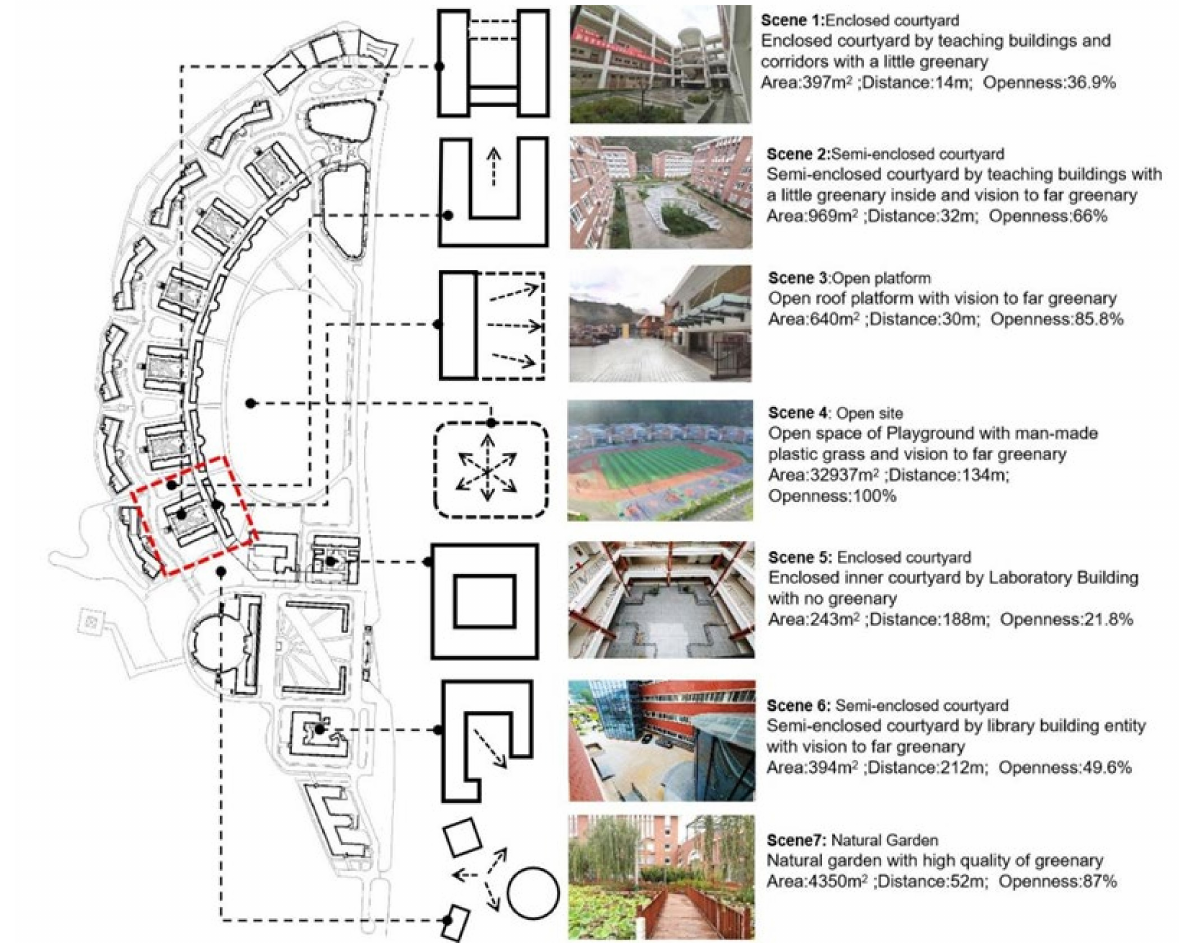
Figure 2. The selected scenes, their location, and their spatial